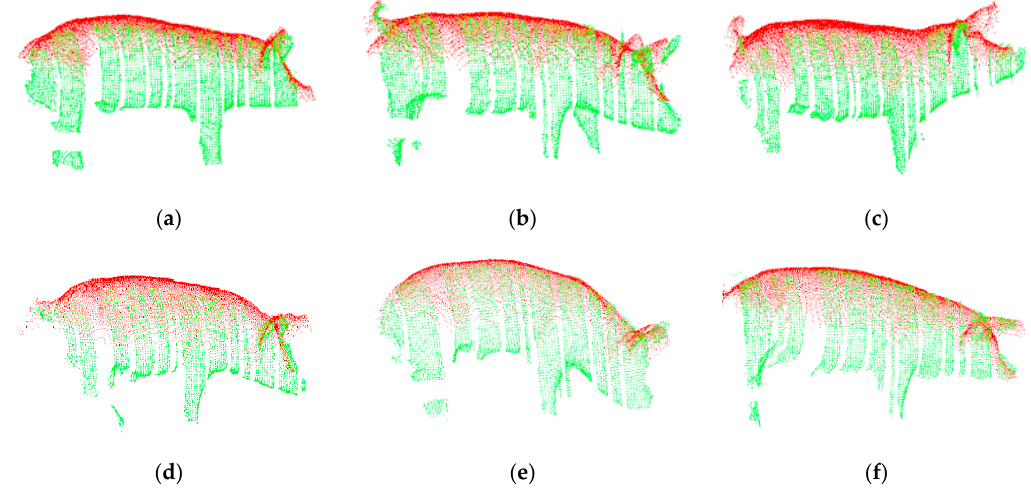
Figure 9. Registration results of the method proposed in this paper: ( a ) Large White pig in a standing pose; ( b ) Large White pig in a walking pose; ( c ) Large White pig in an upward-looking pose; ( d ) Large White pig in a bowing pose; ( e ) Large White pig with an arched back; ( f ) Landrace pig. Ten frames of top-view images and corresponding side-view images of each of the 26 live pigs were selected. After the two-view depth image data of the 26 pigs were preprocessed, the method proposed in this paper and the traditional point cloud registration method were used for registration; in total, 260 live pig point cloud registration results were obtained. To further analyse the accuracy of the proposed registration method and the traditional point cloud registration method, the root mean square error (RMSE) is introduced to quantitatively evaluate the registration error of each of the 260 registration results, as shown in Figure 10. The RMSE was calculated as the average Euclidean distance between corresponding point pairs after registration. The smaller the RMSE value is, the smaller the registration error, and the better the registration e ff ect. Ideally, when the point clouds are fully correctly registered, the average Euclidean distance between corresponding point pairs will be 0. Figure 10 shows that the registration error of the traditional point cloud registration method fluctuates between 26.25 cm and 75.94 cm, while the registration error of the method proposed in this paper ranges from 0.10 cm to 2.34 cm. Thus, the registration error of the proposed method is obviously smaller than that of the traditional point cloud registration method, indicating that the registration accuracy of the proposed method is higher. In summary, this paper proposes a feature- based improved 4PCS registration method for two-view pig point cloud in which the feature-rich ear and tail regions and the back contour region of the side-view point cloud are extracted to serve as the registration regions, thereby effectively reducing the matching error and improving the registration accuracy.